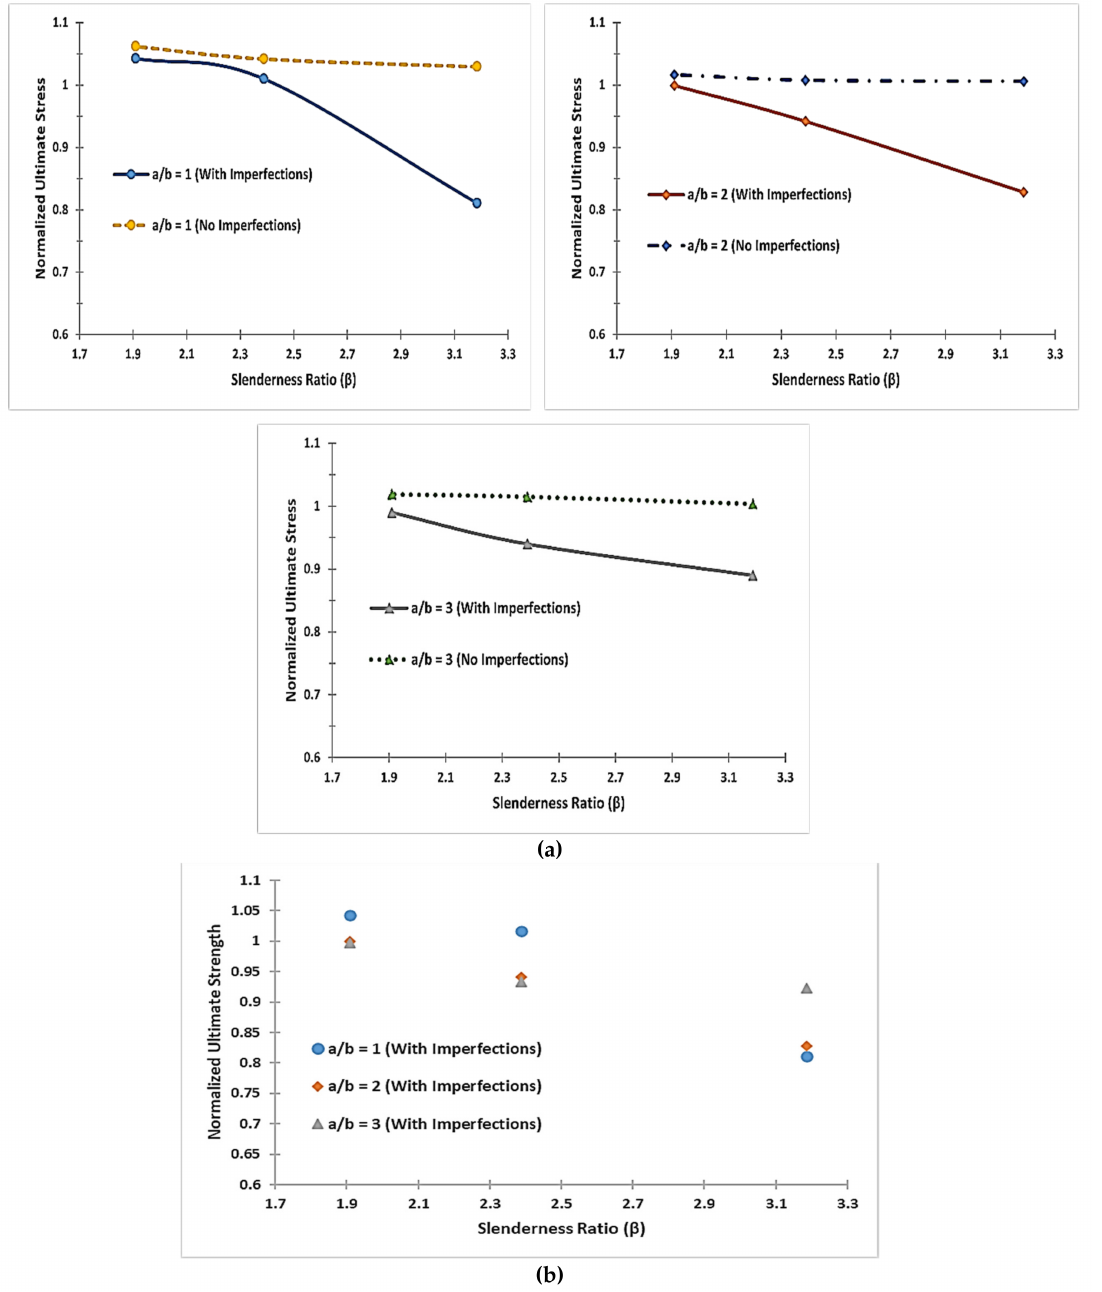
Figure 14. ( a ) Relationship between plate slenderness ratio and ultimate strength with and without welding imperfections for each aspect ratio ( a / b ) and ( b ) Comparison of the ultimate strength between the three aspect ratios with welding